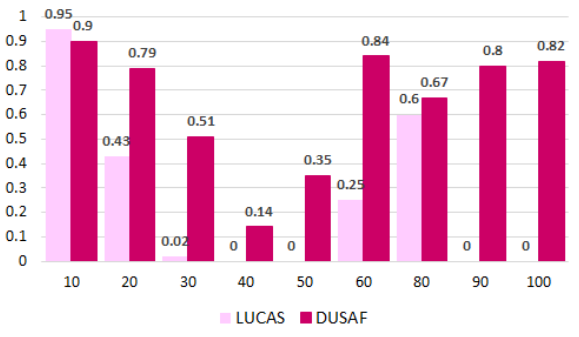
Table 7. Percentage of correctly classified LUCAS